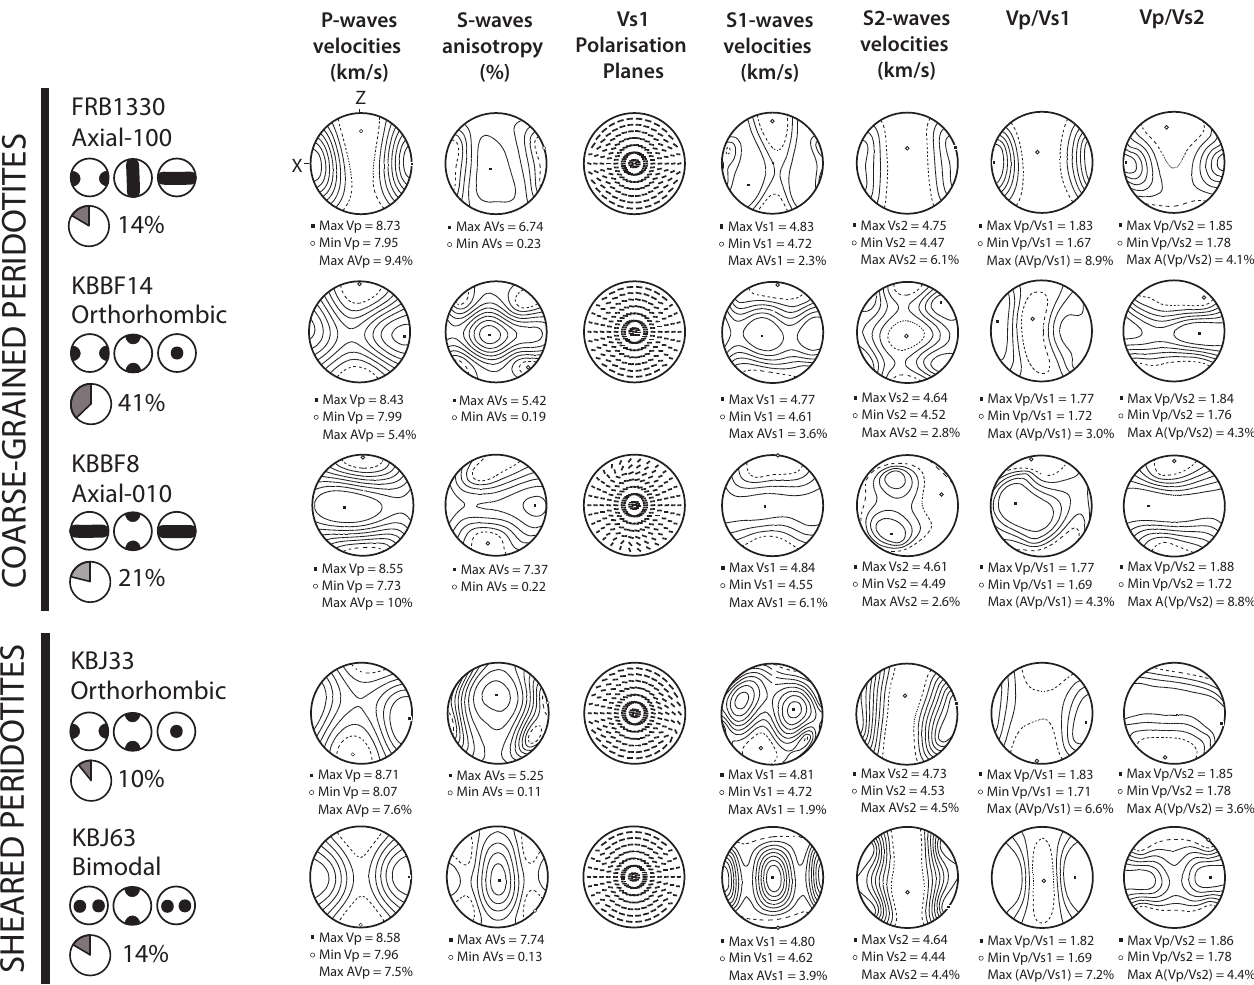
Fig. 2. Calculated seismic properties of the Kaapvaal coarse-grained and sheared peridotites showing different olivine CPO patterns. From left to right, are displayed the 3-D distributions of P wave velocities ( V p ), S wave polarization anisotropy ( V s ), the orientation of fast shear wave polarization plane, S 1 wave velocities ( V S maximum and minimum values,